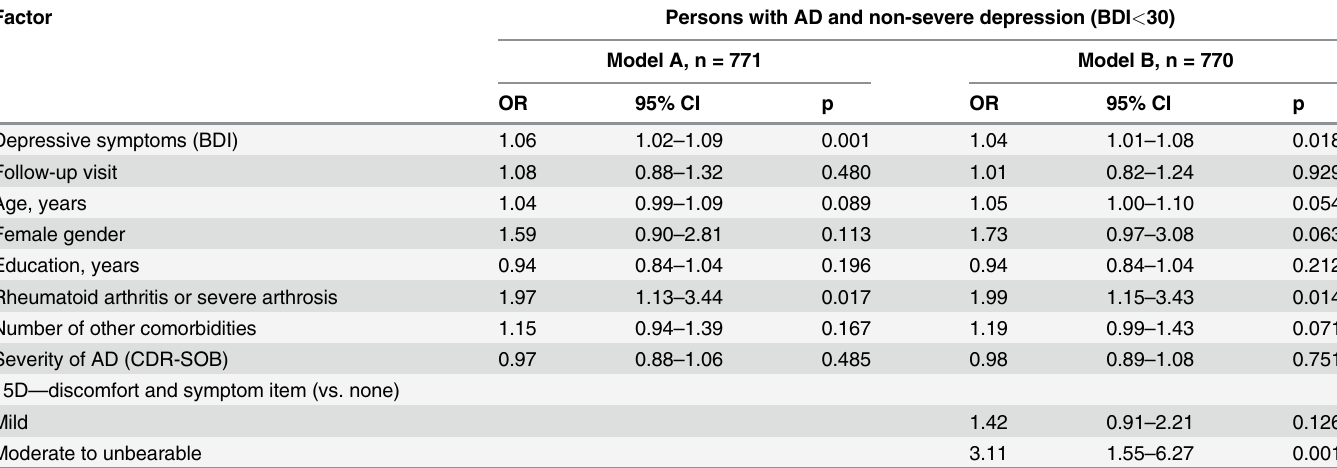
Table 5. Generalized Estimating Equation models (multivariate analyzes) exploring the impact of fi ve year patient factors on analgesic use over time (persons with AD and non-severe depression, BDI < 30).